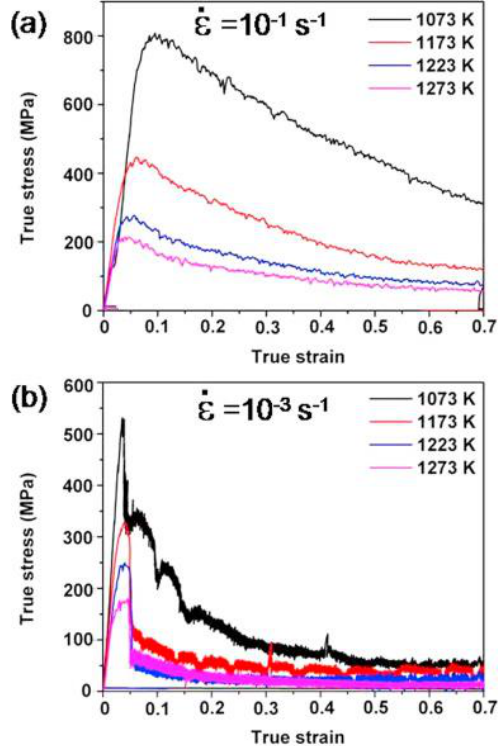
Figure 43. True stress–true strain plots at di ff erent temperatures and strain rates of ( a ) 10 − 1 and ( b ) 10 − 3 s − 1 (reproduced from Reference [162] with